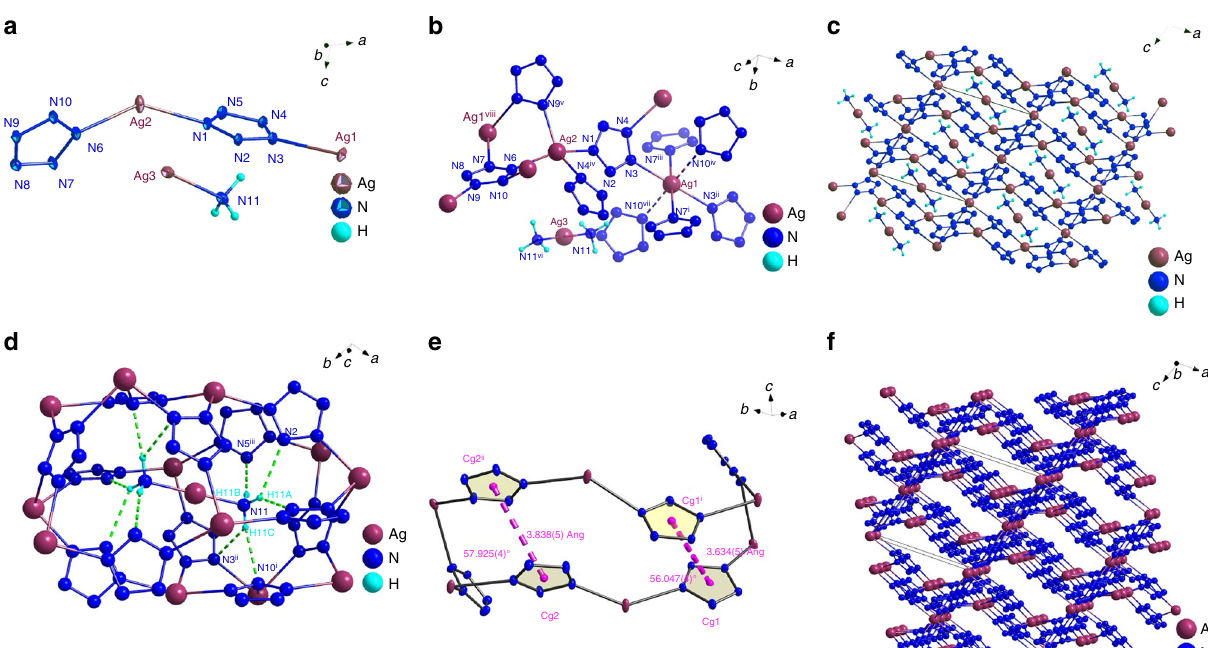
Fig. 3 Crystal structure of [Ag(NH 3 ) 2 ] + [Ag 3 (N 5 ) 4 ] ˉ . a ORTEP plot of [Ag(NH 3 ) 2 ] + [Ag 3 (N 5 ) 4 ] ˉ at the 50% probability level. b The coordinate diagram of [Ag(NH 3 ) 2 ] + [Ag 3 (N 5 ) 4 ] ˉ . c Unit cell view along the b axis. d Schematic representation of the hydrogen-bonded motifs in the crystal structure: H-bonds are indicated as dotted lines. e π – π stacking interaction in the crystal structure (Cg1 and Cg2 were the centers of cyclo-N 5 ˉ ). f The 3D framework of [Ag(NH 3 ) 2 ] + [Ag 3 (N 5 ) 4 ]